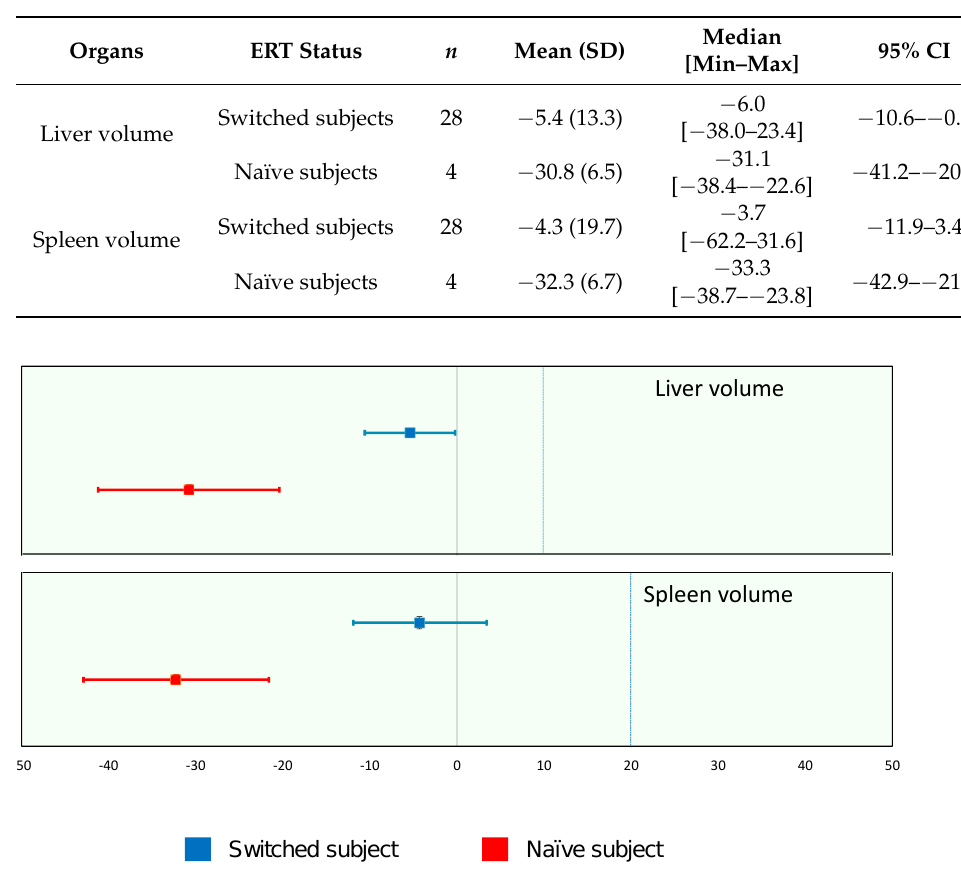
Figure 9. Relative changes in the liver and spleen volumes from baseline to week 52. The blue dotted lines are suggested thresholds of clinically significant changes (10% for liver volume and 20% for spleen volume); values below these can be interpreted as either the stabilization or improvement of hepatosplenomegaly (updated from